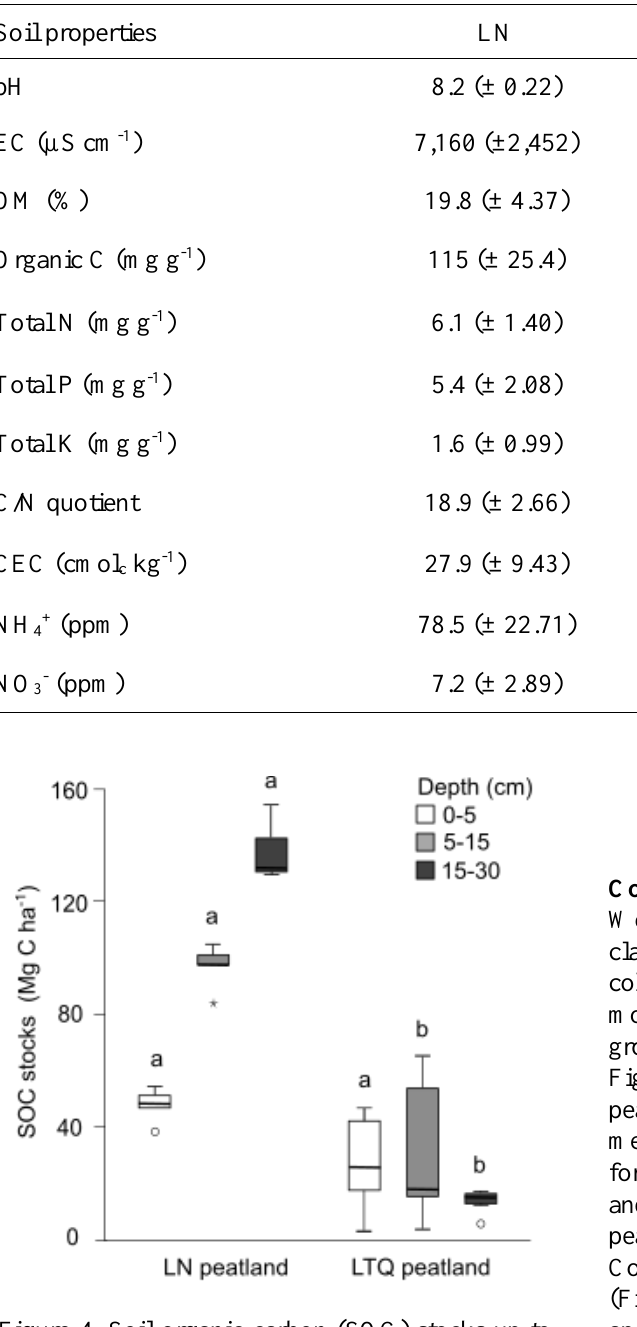
Figure 4. Soil organic carbon (SOC) stocks up to 30 cm depth, comparing three discrete depth intervals between peatlands. LN: peatland associated with Laguna Negra, LTQ: peatland associated with Laguna Tres Quebradas. Different letters indicate significant differences (p < 0.05) in SOC stocks between peatlands for each depth interval